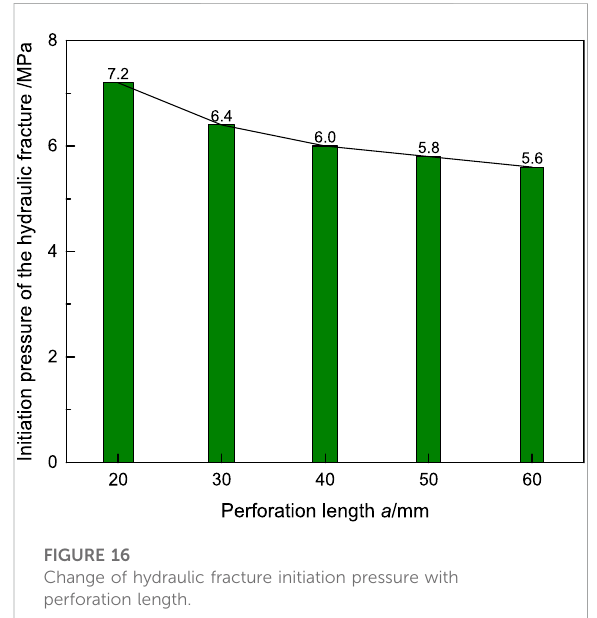
FIGURE 16 Change of hydraulic fracture initiation pressure with perforation